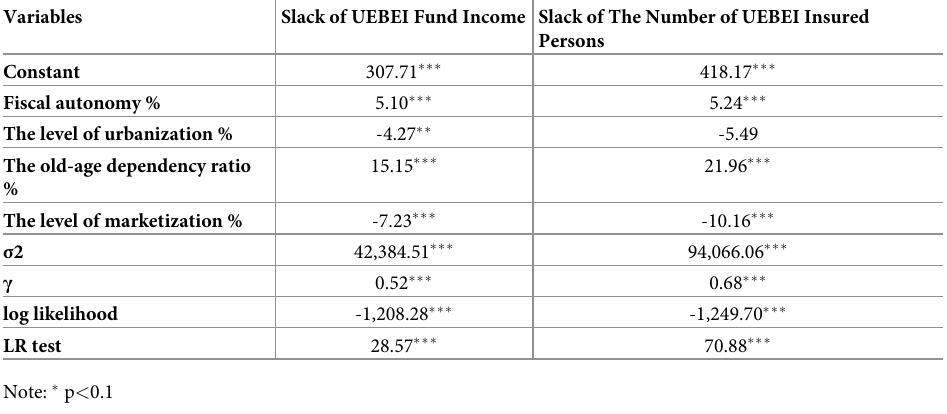
Table 4. Results of the SFA model in Stage